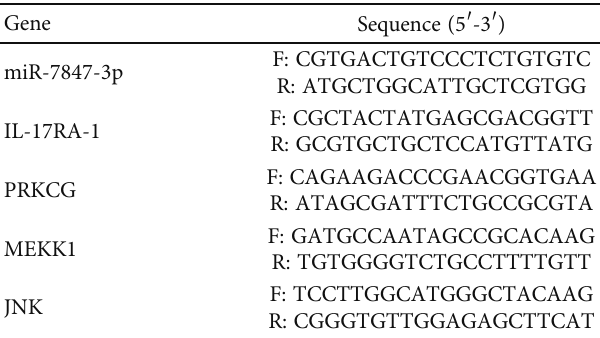
work, and GO enrichment analysis of mRNAs in ceRNAs Table 1: Primer sequences.